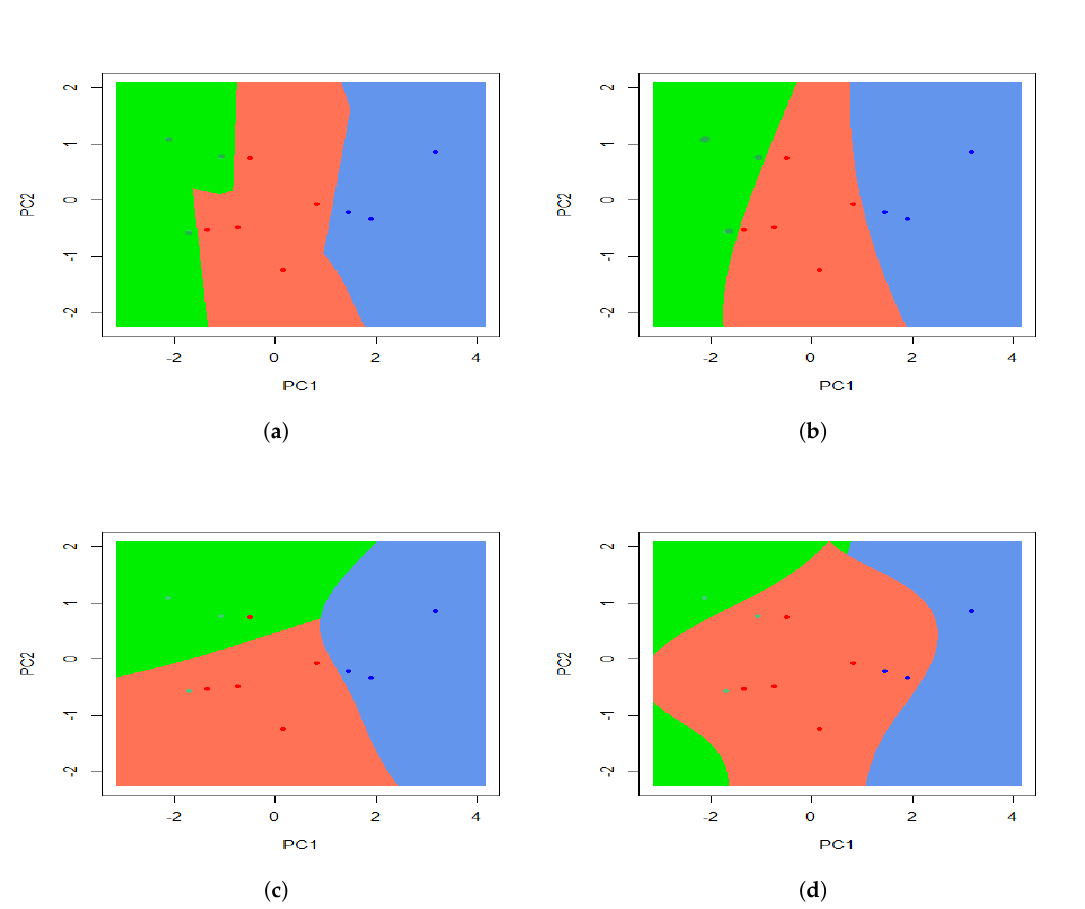
Figure 6. Decision borders for each classifier. Original data are embedded into a bi-dimensional space using PCA to graphically depict the classification ability of the considered algorithms. ( a ) k-NN, ( b ) Bayesian classifier, ( c ) SVM (Sigmoid kernel), ( d ) SVM (Polynomial kernel).